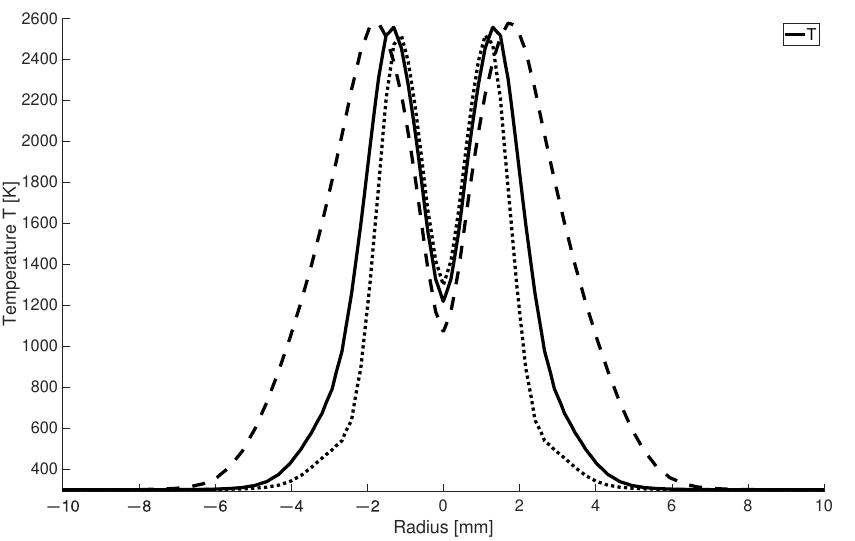
Figure 8. Radial temperature distribution at 2.5 mm for different λ ; solid line: λ = 1.5; dotted lines: λ = 2 ; dashed lines: λ =